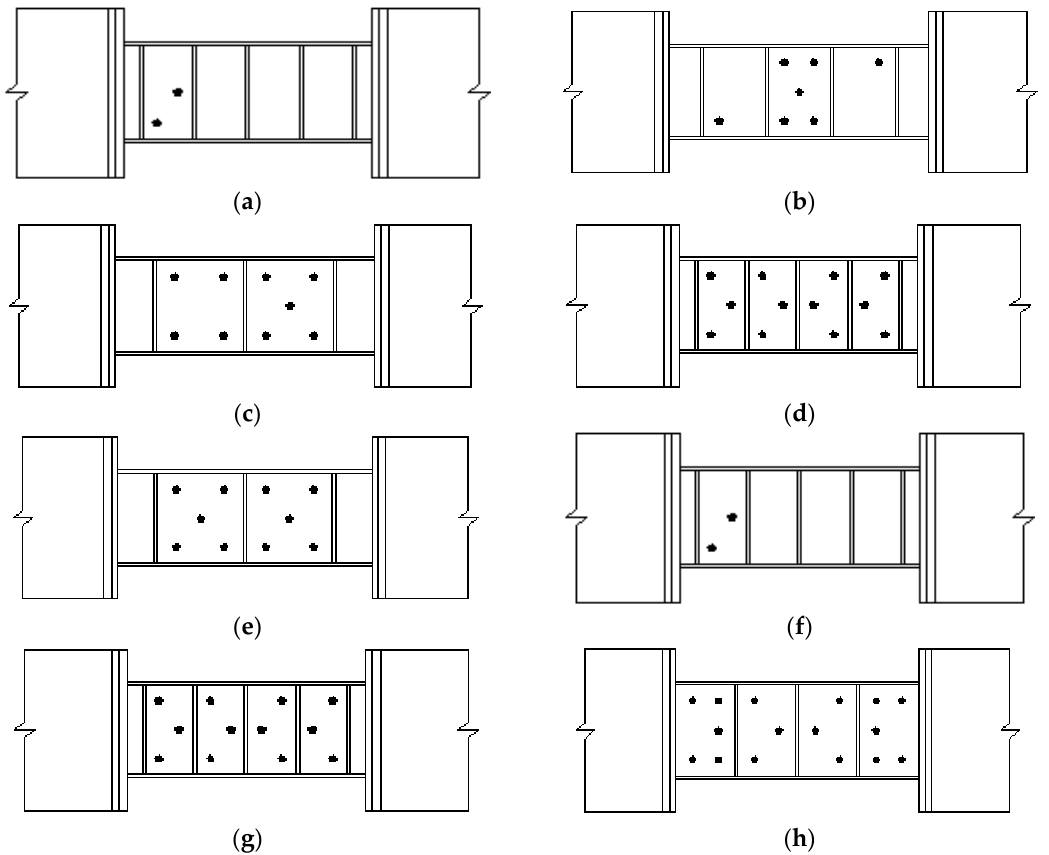
Figure 8. Yielded points on the web of each specimen. ( a ) L1; ( b ) L2; (c) L3; ( d ) L4; ( e ) L5; ( f ) L6; ( g ) L7; ( h ) L8.